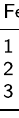
Table 7 Ethereum prediction errors. Root Mean Square Error (RMSE) of predictions